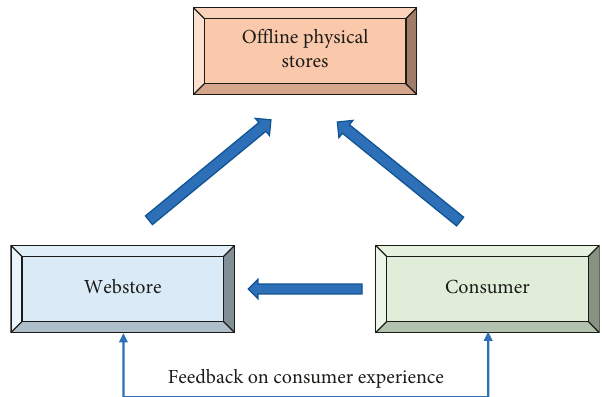
Figure 2: The main process of the O2O